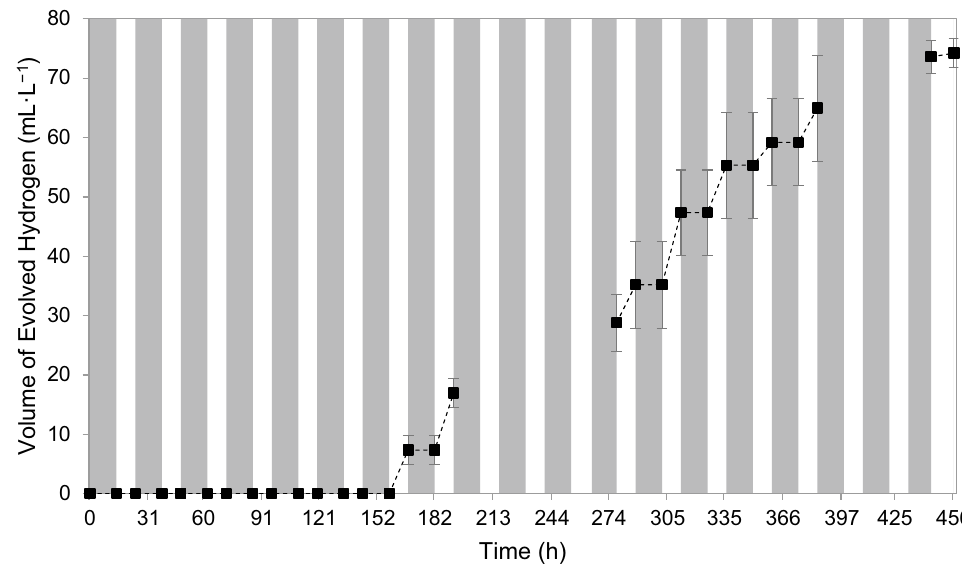
Fig. 4 Cumulative volume of evolved hydrogen gas per TPBR working volume (dark periods indicated with grey areas) — each data point represents the mean of triplicates with the error indicated as standard